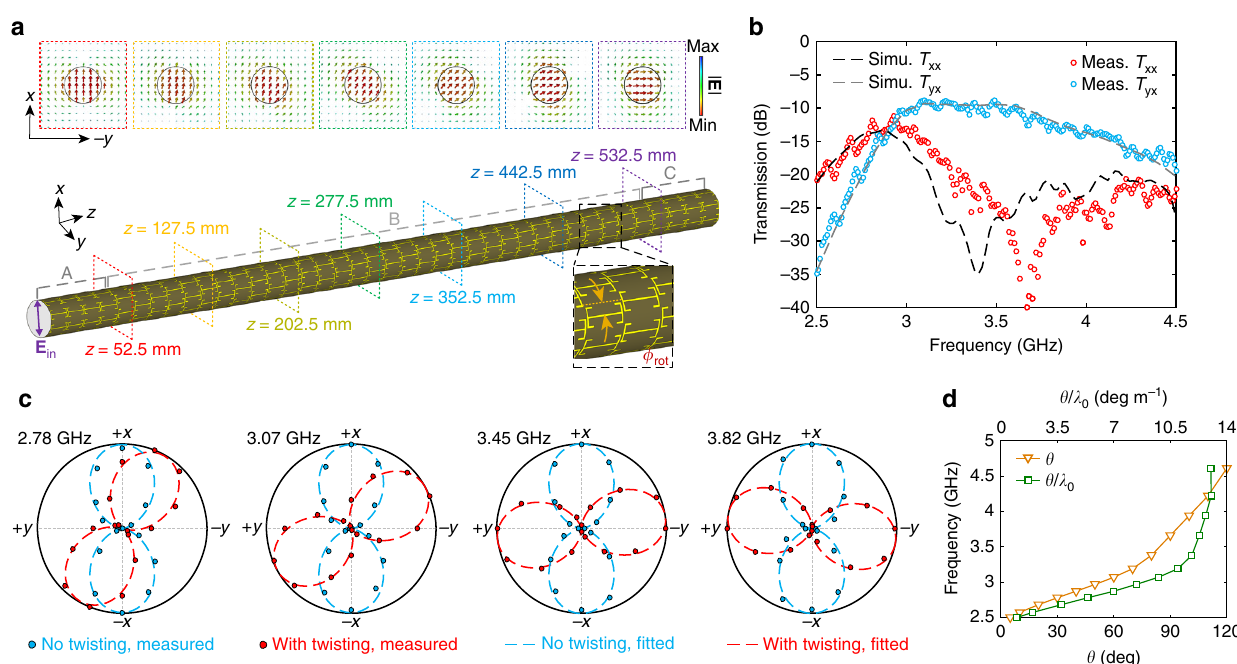
Fig. 3 A sub-wavelength dielectric waveguide coated by a single-layer twisting metasurface. a Con fi guration and snapshots of the vector electric fi eld distribution at 3.45 GHz in the x - y plane at seven different positions along the axis of the rod when excited by an x polarized probe. Sections A and C contain unit cells near the two ends, while section B contains unit cells in the center. b Measured and simulated co-polarized ( T xx ) and cross-polarized ( T yx ) transmission between the transmitting and receiving probes. c Measured state-of-polarization patterns of the Te fl on rod waveguide coated by the metasurface guiding layer with and without twisting perturbation at different frequencies. d Measured rotation angle and the rotation angle per wavelength as a function of